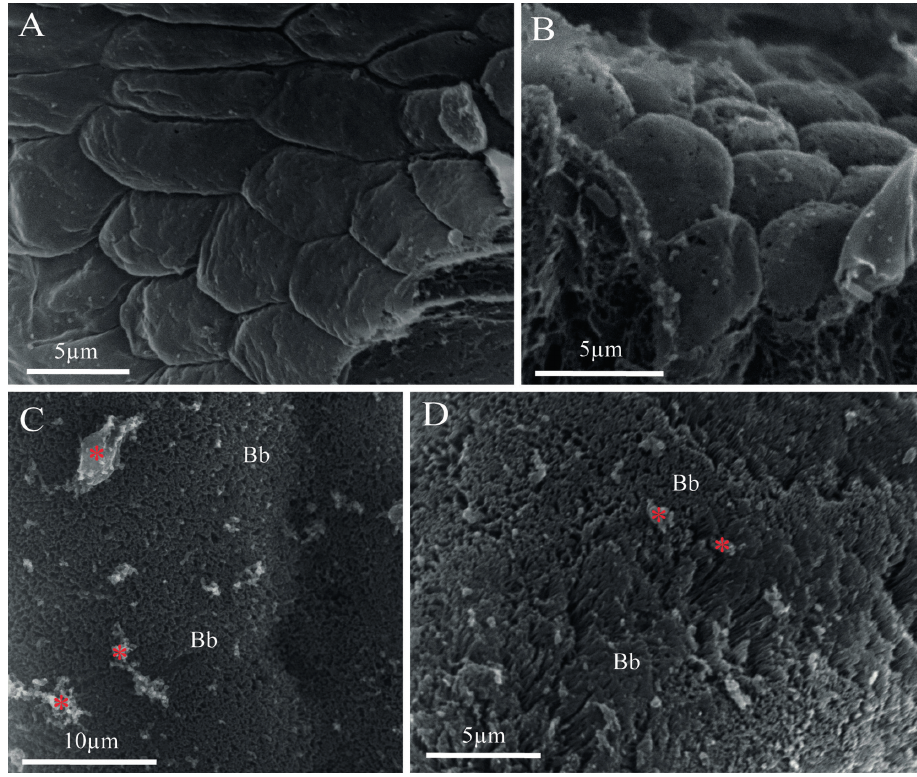
FIGURE 4 | Scanning Electron Microscopy (SEM) microphotographs of the digestive tract of Paracheirodon axelrodi . A-B. SEM view of mucosal surface showing a polyhedral surface of the epithelial cells in two different sections of the stomach. C. SEM view of mucosal surface of the intestine showing the brush border (Bb) present in the apical portion of the epithelium and abundant mucous secretion (red asterisk) from the GCs. D. Detail with higher magnification of C , in which the Bb is better defined.